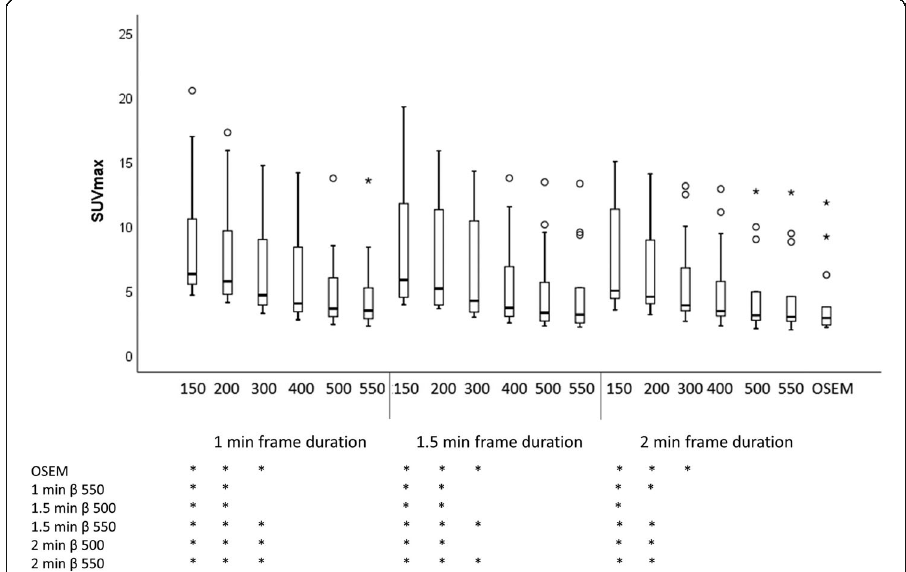
Fig. 3 Boxplot for SUV max in pathologic lymph nodes. Stars below the graph indicate the combinations of reconstruction parameters that reached statistical